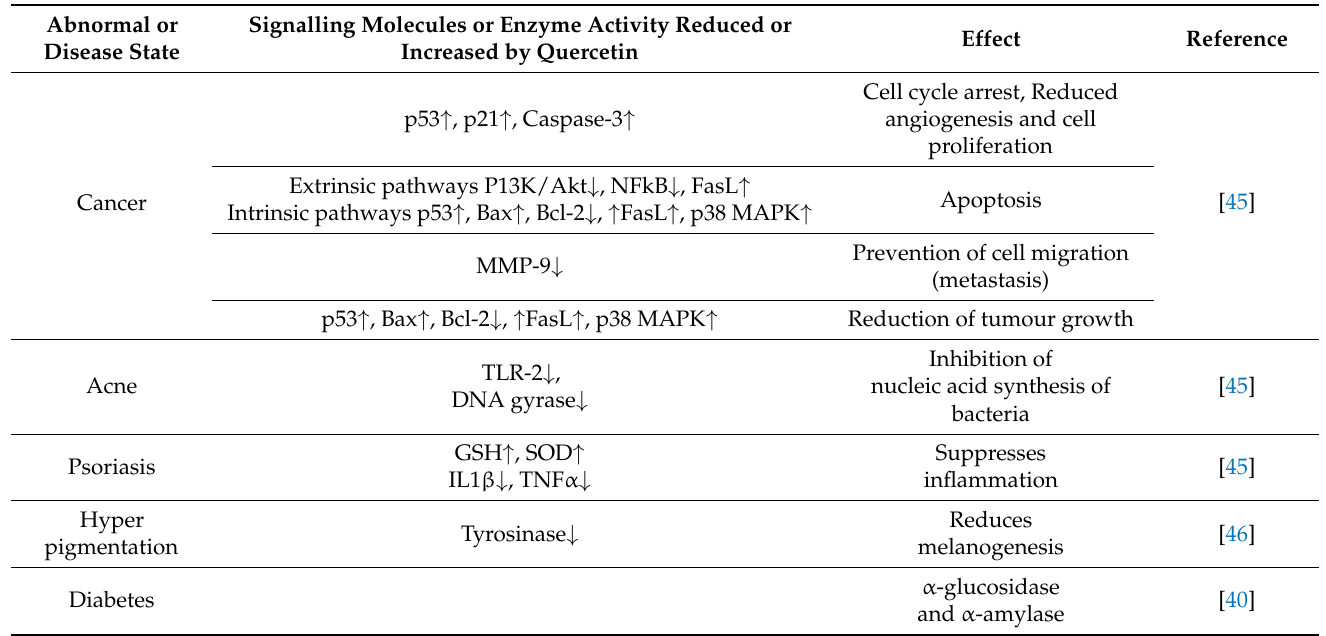
Table 1. Some examples of the effects of quercetin on signalling molecules. ↑ indicates an increase, ↓ indicates a decrease. Data from references